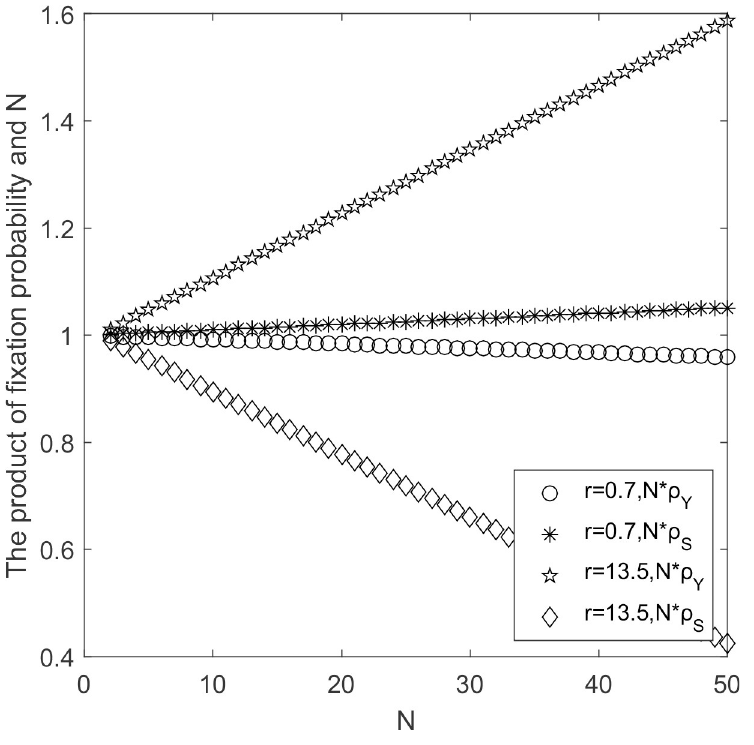
Fig 8. N � ρ Y /N � ρ S ~ r change